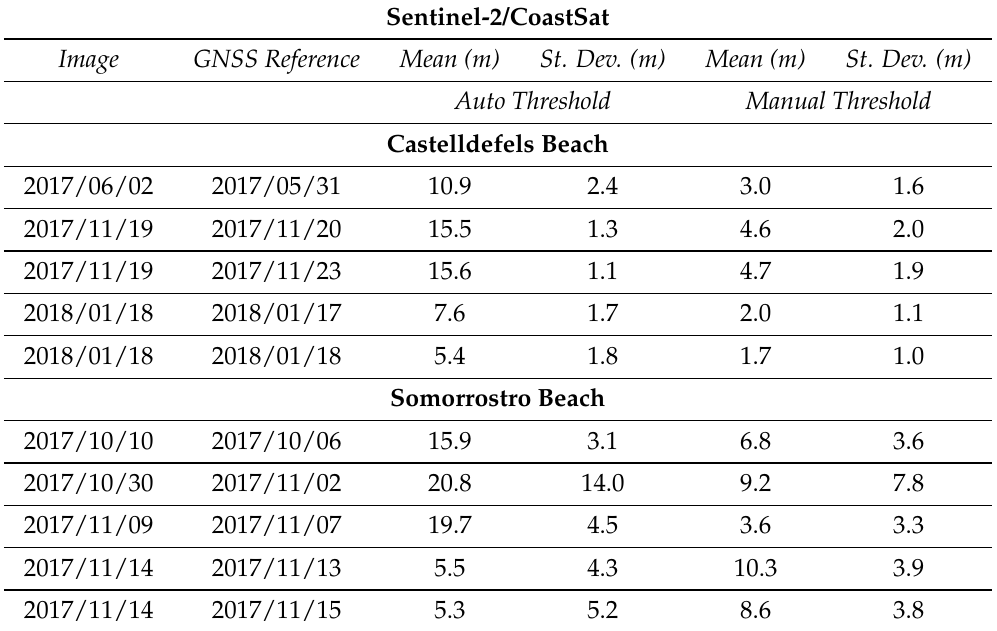
Table 7. Mean and standard deviation of the distances between Sentinel-2 shorelines and GNSS reference points in Castelldefels and in Somorrostro beaches by using CoastSat with both automatic and manual thresholds.